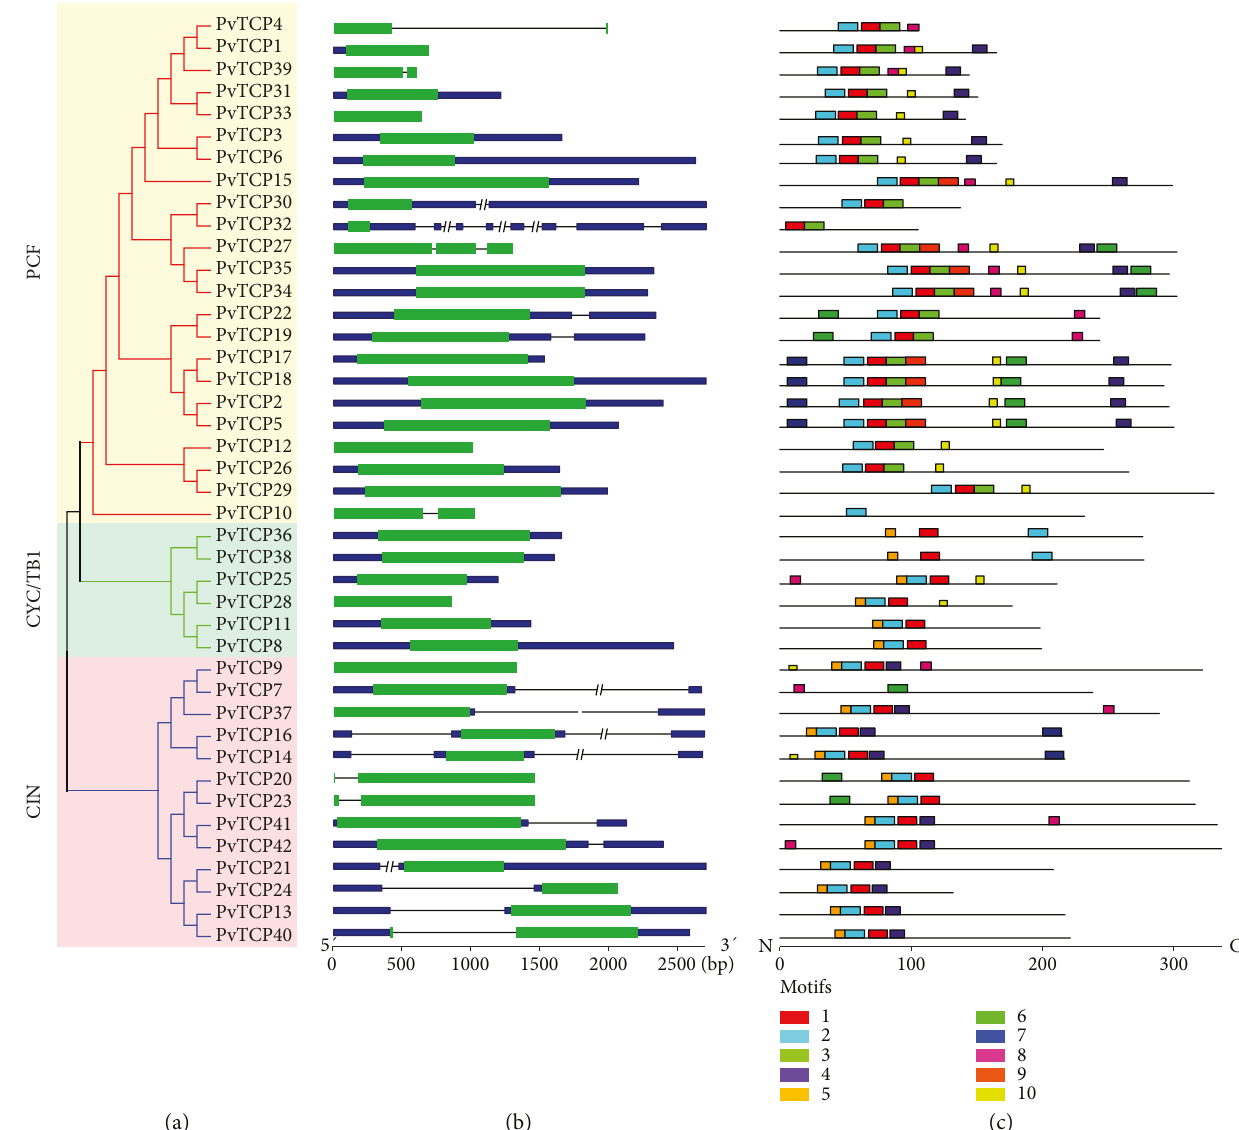
Figure 4: Gene structures and motif locations of switchgrass TCP genes. (a) Three clades were classi fi ed according to an unrooted NJ tree, which were constructed using PvTCP peptides. (b) Exon/intron arrangements of the PvTCP gene. Exons, introns, and untranslated region (UTR) were represented by green boxes, black lines, and blue boxes, respectively. Nucleic acid lengths are indicated by the scale at the bottom; bp =base pair. (c) Schematic representation of conserved motifs in the PvTCP proteins predicted by the MEME program. Each motif is represented by a number in the colored box. The black lines represented the nonconserved sequences. Lengths of motifs for each PvTCP protein were displayed proportionally. aa=amino